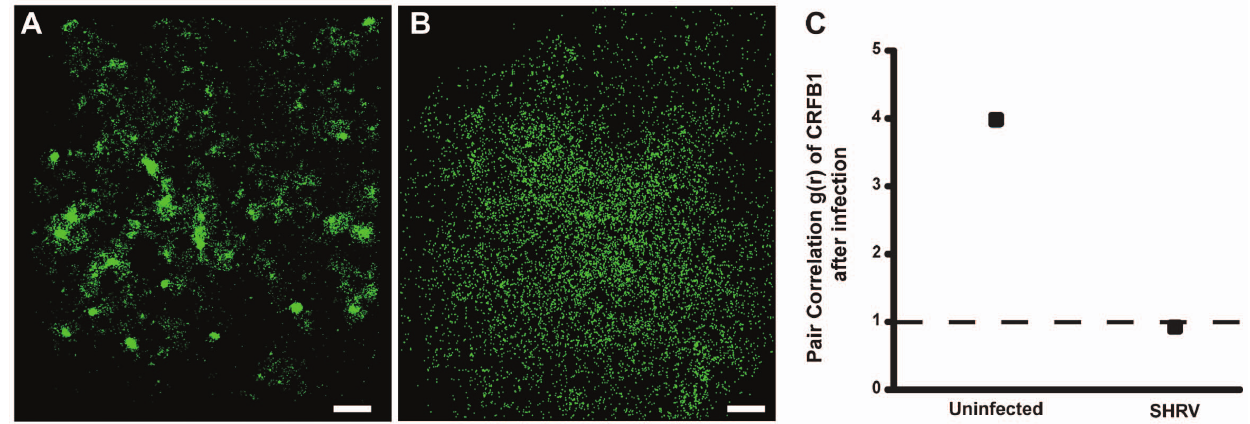
Figure 4. CRFB1 becomes dispersed as a result of whole virus infection invitro . ZFL cells were infected 24 h post transfection and fixed prior to imaging. For all images, 60 6 /1.2 NA magnification. Scale bars, 1 m m. Shown for each part is the surface of one cell representative of the experiment. A) Uninfected cells overexpressing CRFB1 demonstrate that the receptor exists in clustered patches indicative of caveolae. B) Cells infected with SHRV demonstrate that CRFB1 becomes dispersed as a result of virus infection by 24 hpi. C) Pair correlation analysis confirms that compared to uninfected cells, CRFB1 becomes dispersed after infection. Values of g(r) in cells with SHRV infection are considered to be random in comparison to values in cells that remain uninfected (n $ 8 cells per treatment).